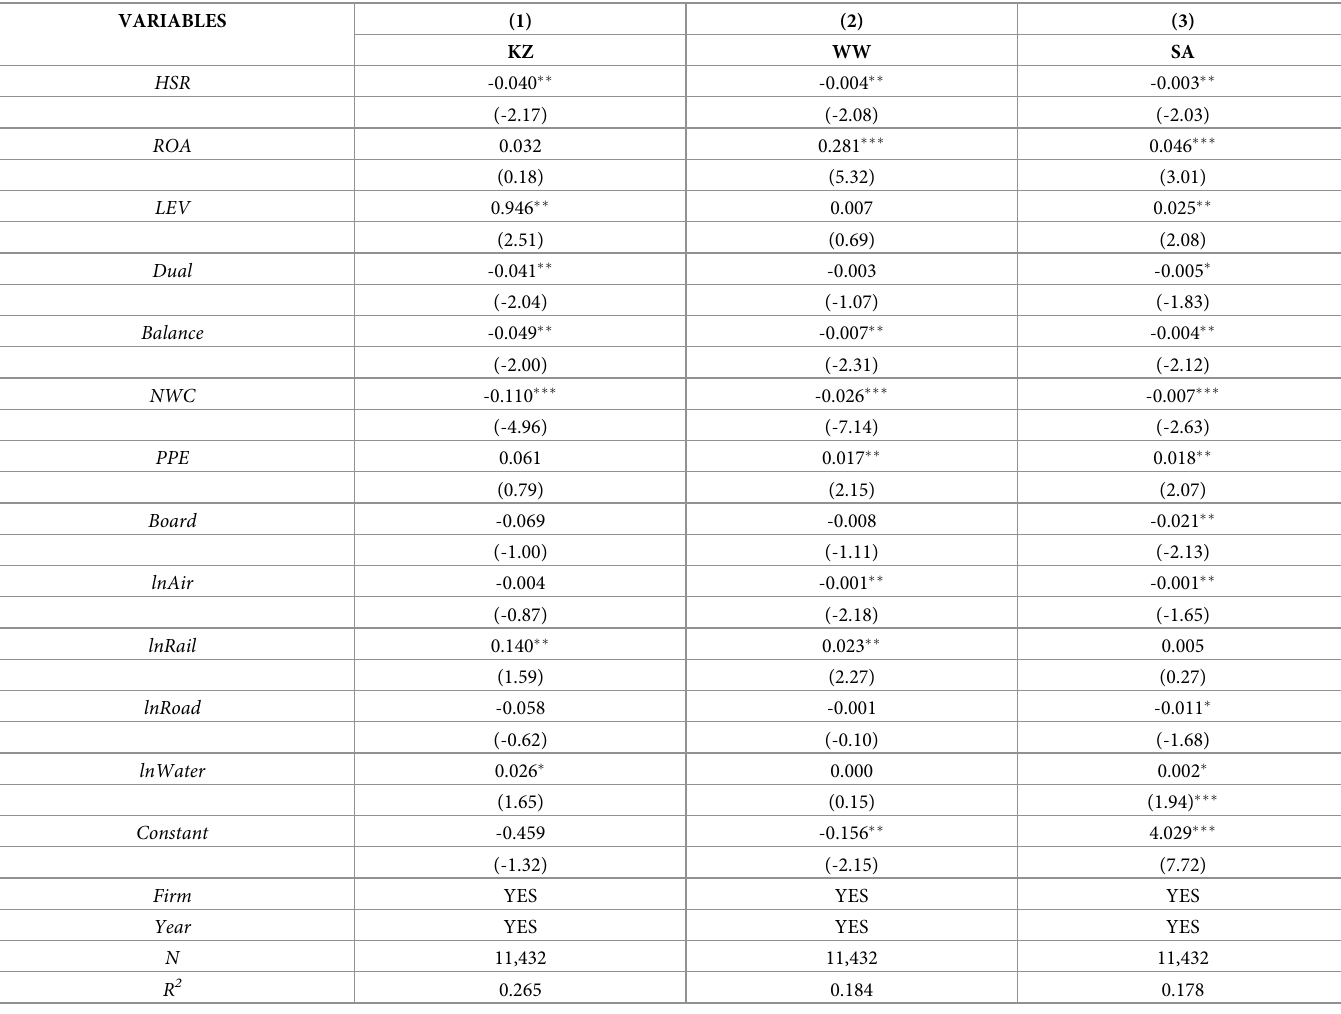
Table 3. Benchmark regression